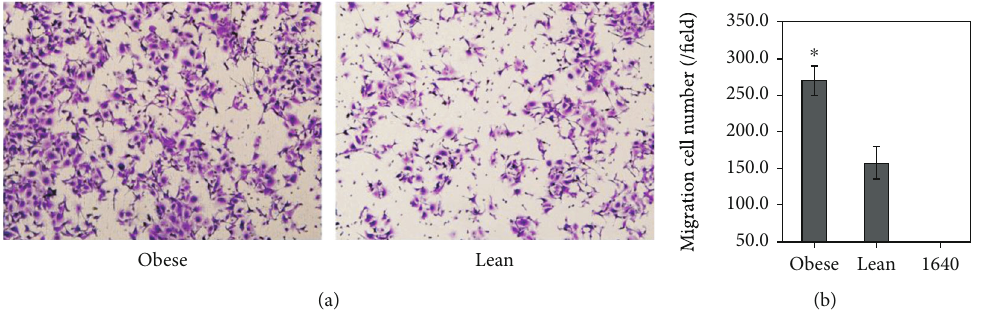
Figure 6: E ff ects of obesity on TE-1 cell migration. Obesity prompted signi fi cantly TE-1 cell migration than the lean ( 270 : 1 ± 19 : 8 versus 158 : 0 ± 21 : 6 / fi eld, ∗ P < 0 : 001 ). Magni fi cation, × 200.